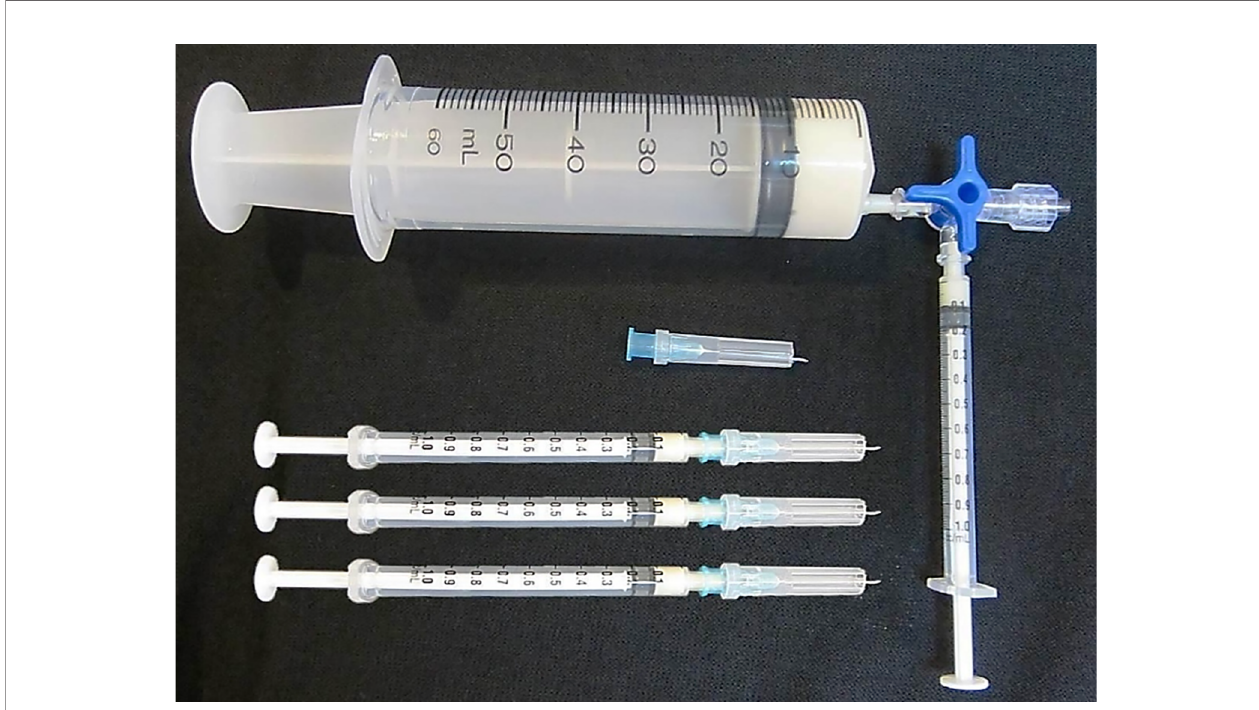
FIGURE 1 | The modi fi ed tuberculin syringes used to deliver 0.1 ml of Freund ’ s adjuvant emulsi fi ed immunogen into the horse subcutaneous site at the depth of 2-3 mm from the skin surface according to the ‘ low dose, low volume multi-site ’ immunization. Please see details in